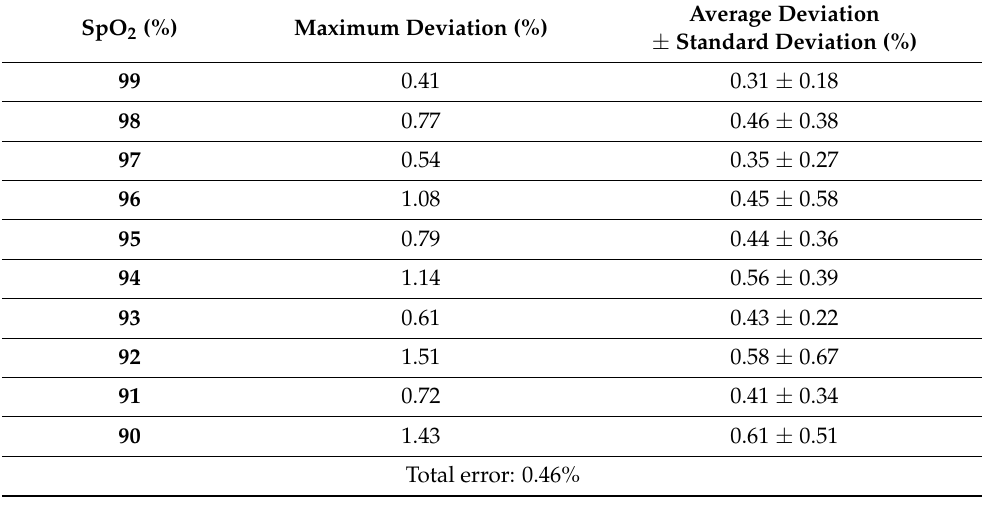
Table 7. Deviation of each SpO 2 .